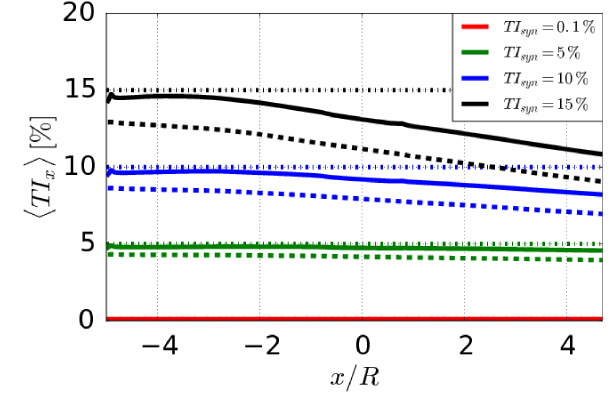
Figure 11. Longitudinal evolution of turbulence intensities for dif- ferent turbulent intensities at the inlet in HIT without rotor effects. For each case the mean value (cid:104) TI (cid:105) is shown with the resolved TI (cid:104) TI res (cid:105) (dashed line), resolved and subgrid scale TI (cid:104) TI res (cid:105)+(cid:104) TI sgs (cid:105) (solid line), and the inlet TI TI syn (dotted line) as reference. The sudden spike at the end of the domain is caused by the outlet con- dition, and its influence is restricted to the last computational cell before the